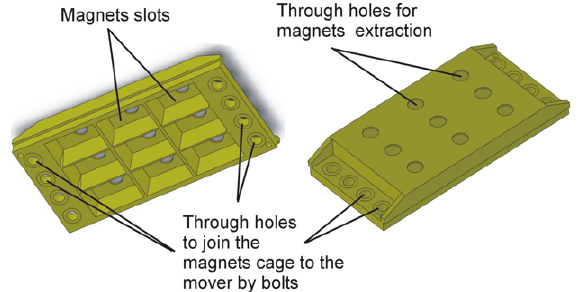
Figure 4: Retention cages of the magnets.